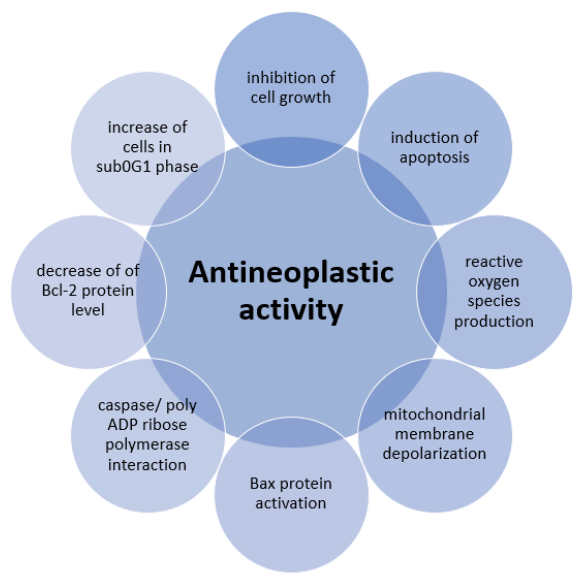
Figure 7. Antineoplastic activity of thymol.